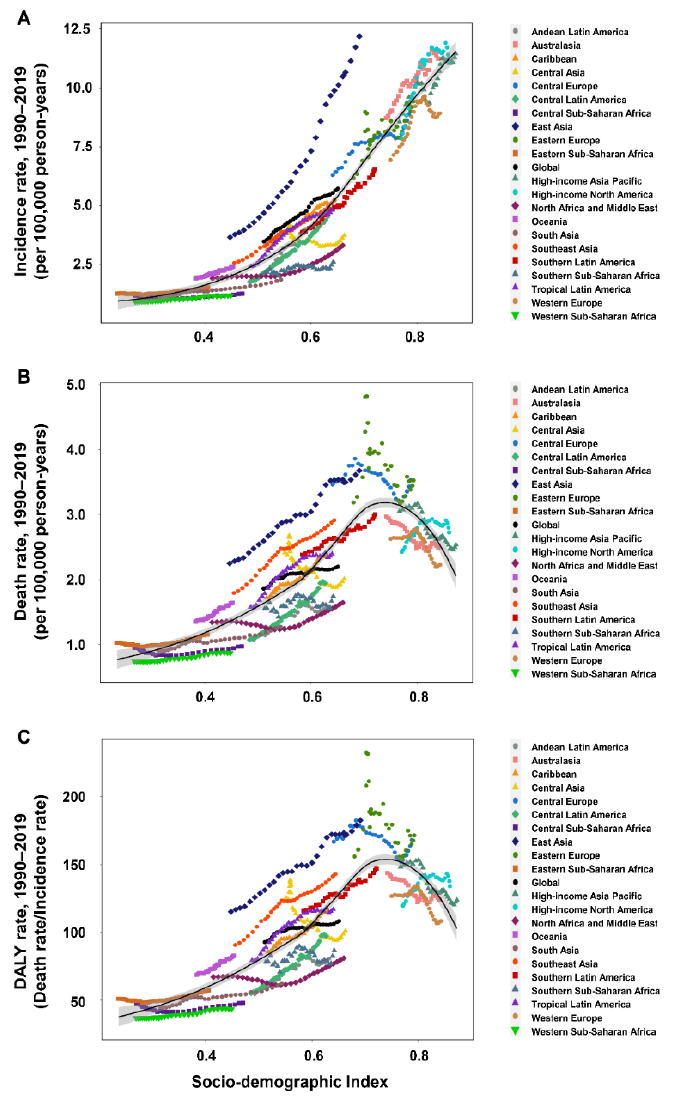
Figure 3. The incidence rate ( A ), death rate ( B ), and DALY rate ( C ) of early-onset CRC worldwide and in 21 GBD regions by SDI, 1990–2019. CRC: colorectal cancer; DALY: disability-adjusted life-year; GBD: Global Burden of Disease; SDI: sociodemographic index.